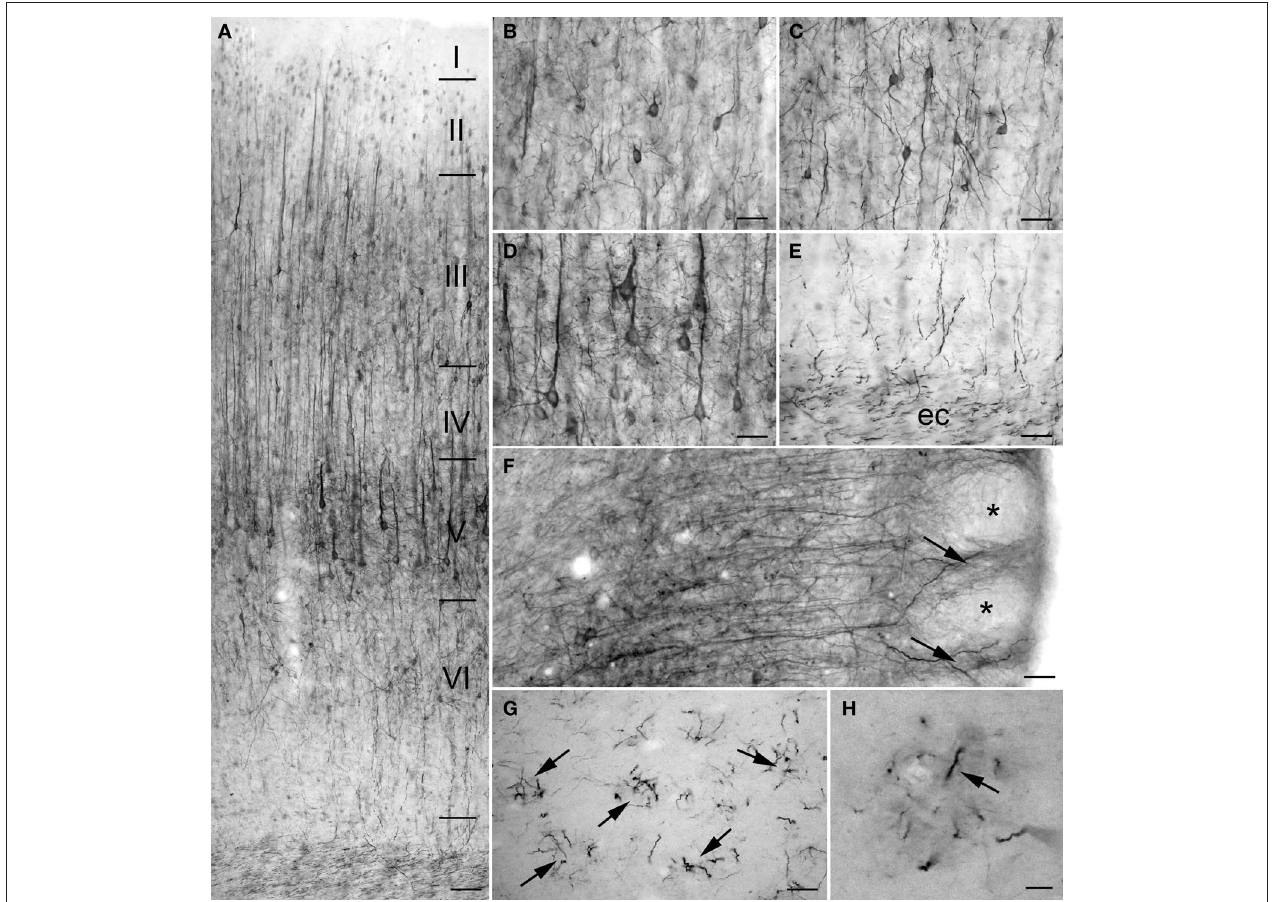
cortex immunostained with PlexinA4. Apical dendrites from the pyramidal neurons are seen to form bundles in the upper layers of cortex (arrows) leaving unstained spaces (*) between them. A similar arrangement is visible in sagittal sections of cingulate cortex ( g and H ) where distinct bundles (arrows) of PlexinA4 positive fibers can be identified. ec, External capsule. (A) 200 μm, (B–g) 100 μm, (H) 25